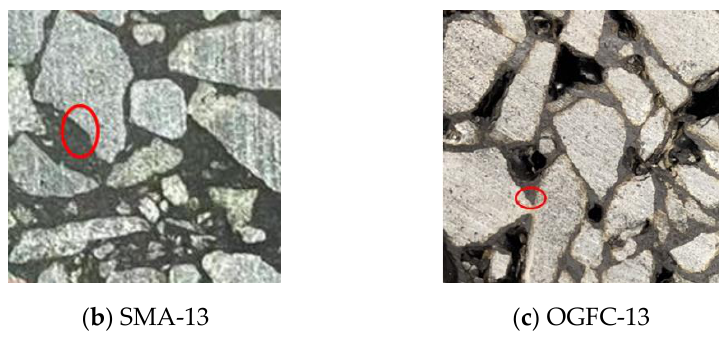
Figure 6. Asphalt mixture pictures.